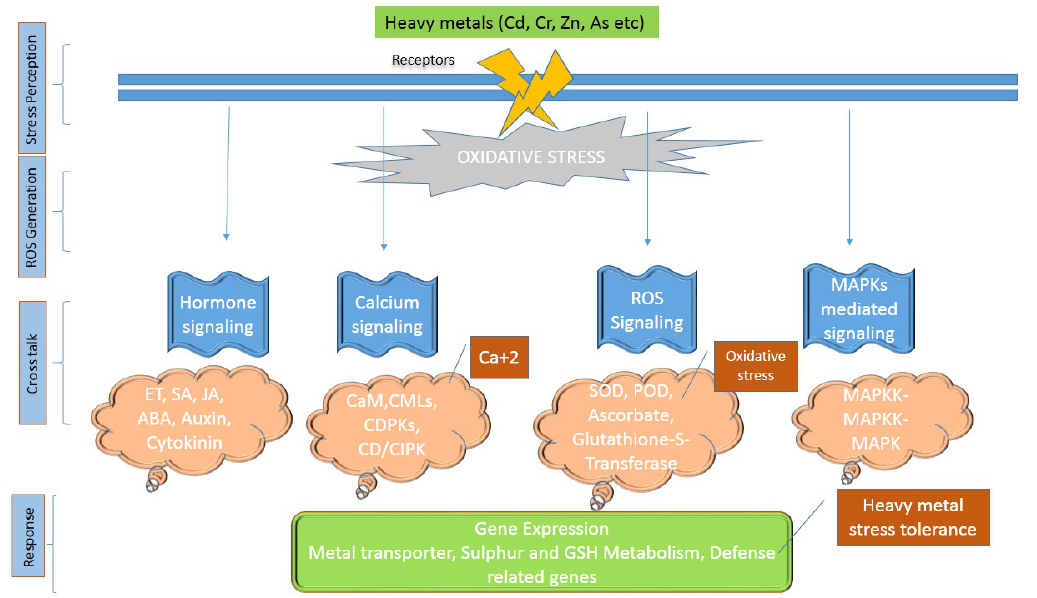
Figure 1. Heavy metals stress signaling in plants.